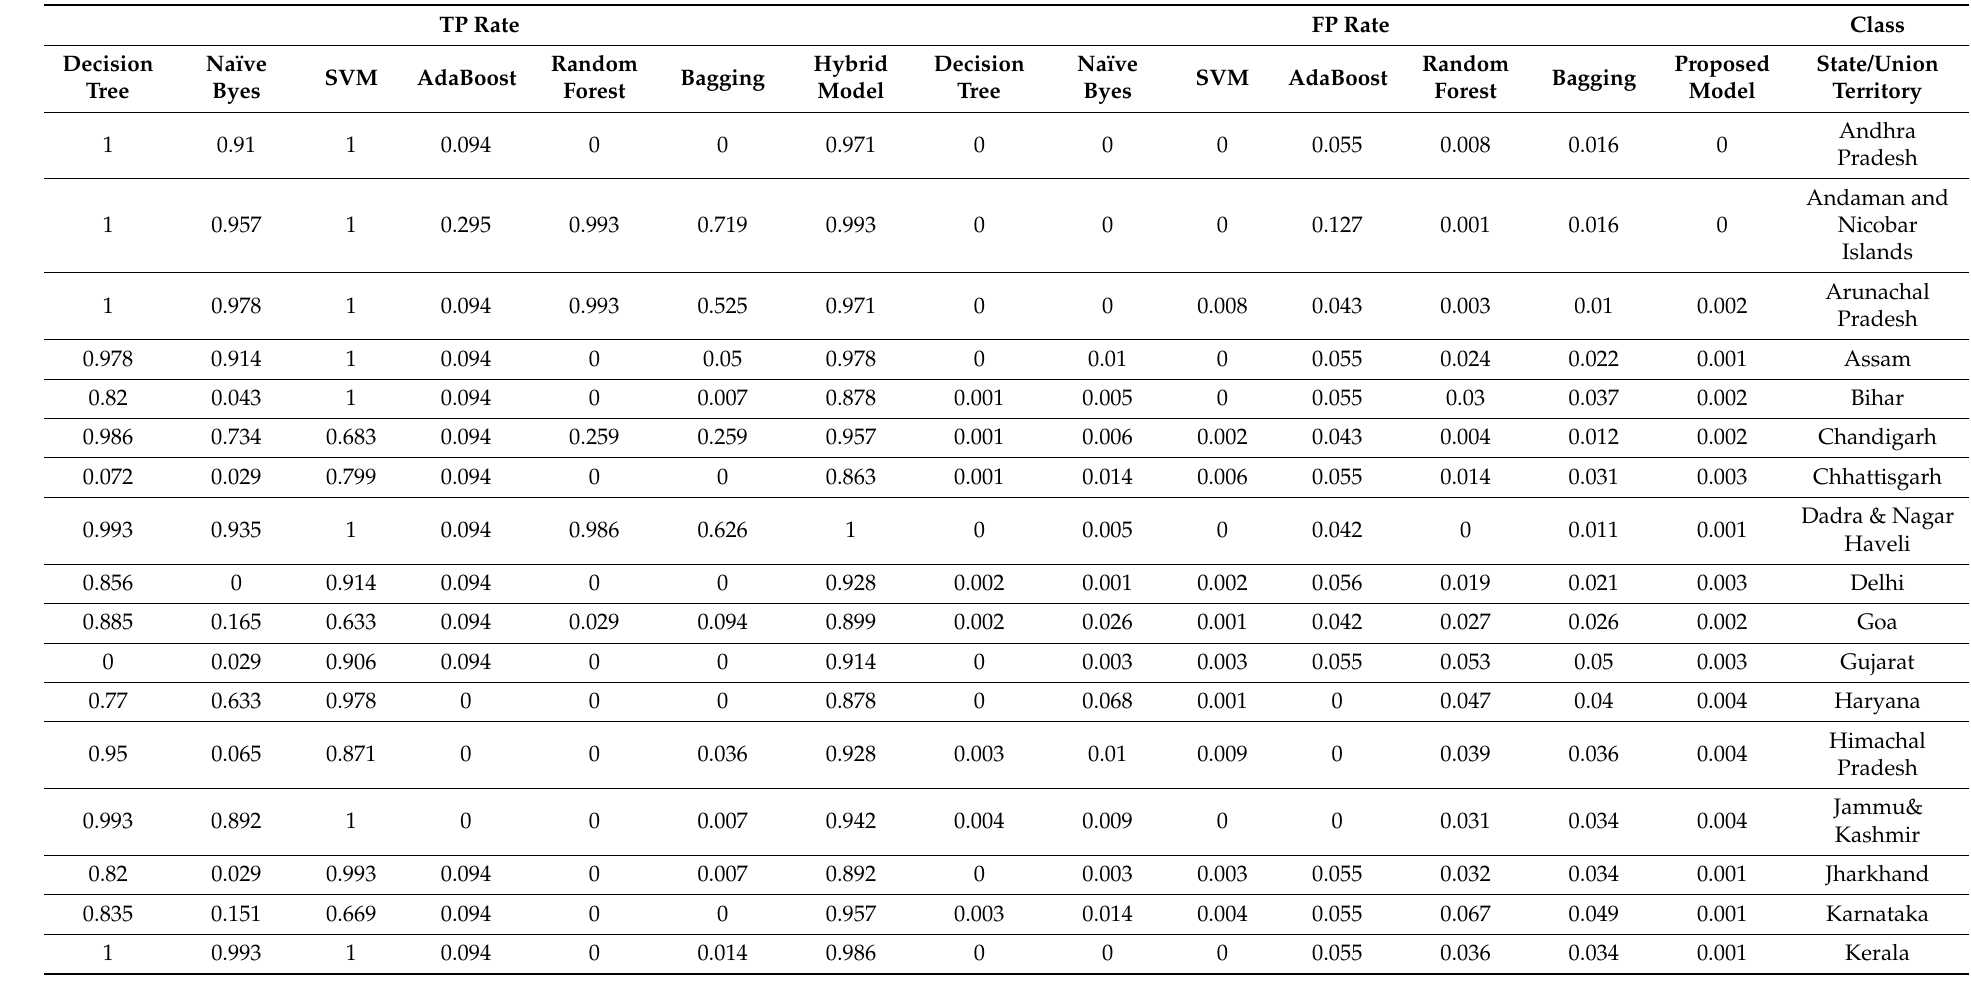
Table 5. Detailed Accuracy (TP, FP Rate) for each class Using Machine Learning Classifiers. TP